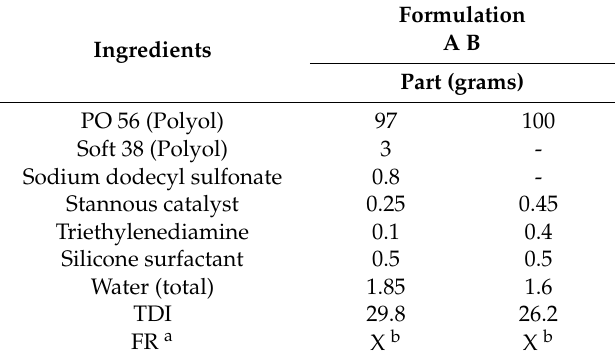
Table 2. PU foam formulations A and B.